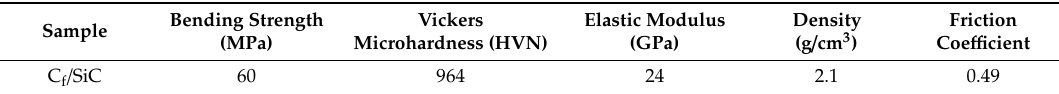
Table 6. Mechanical properties measured for the C f / SiC composite material infiltrated under optimum